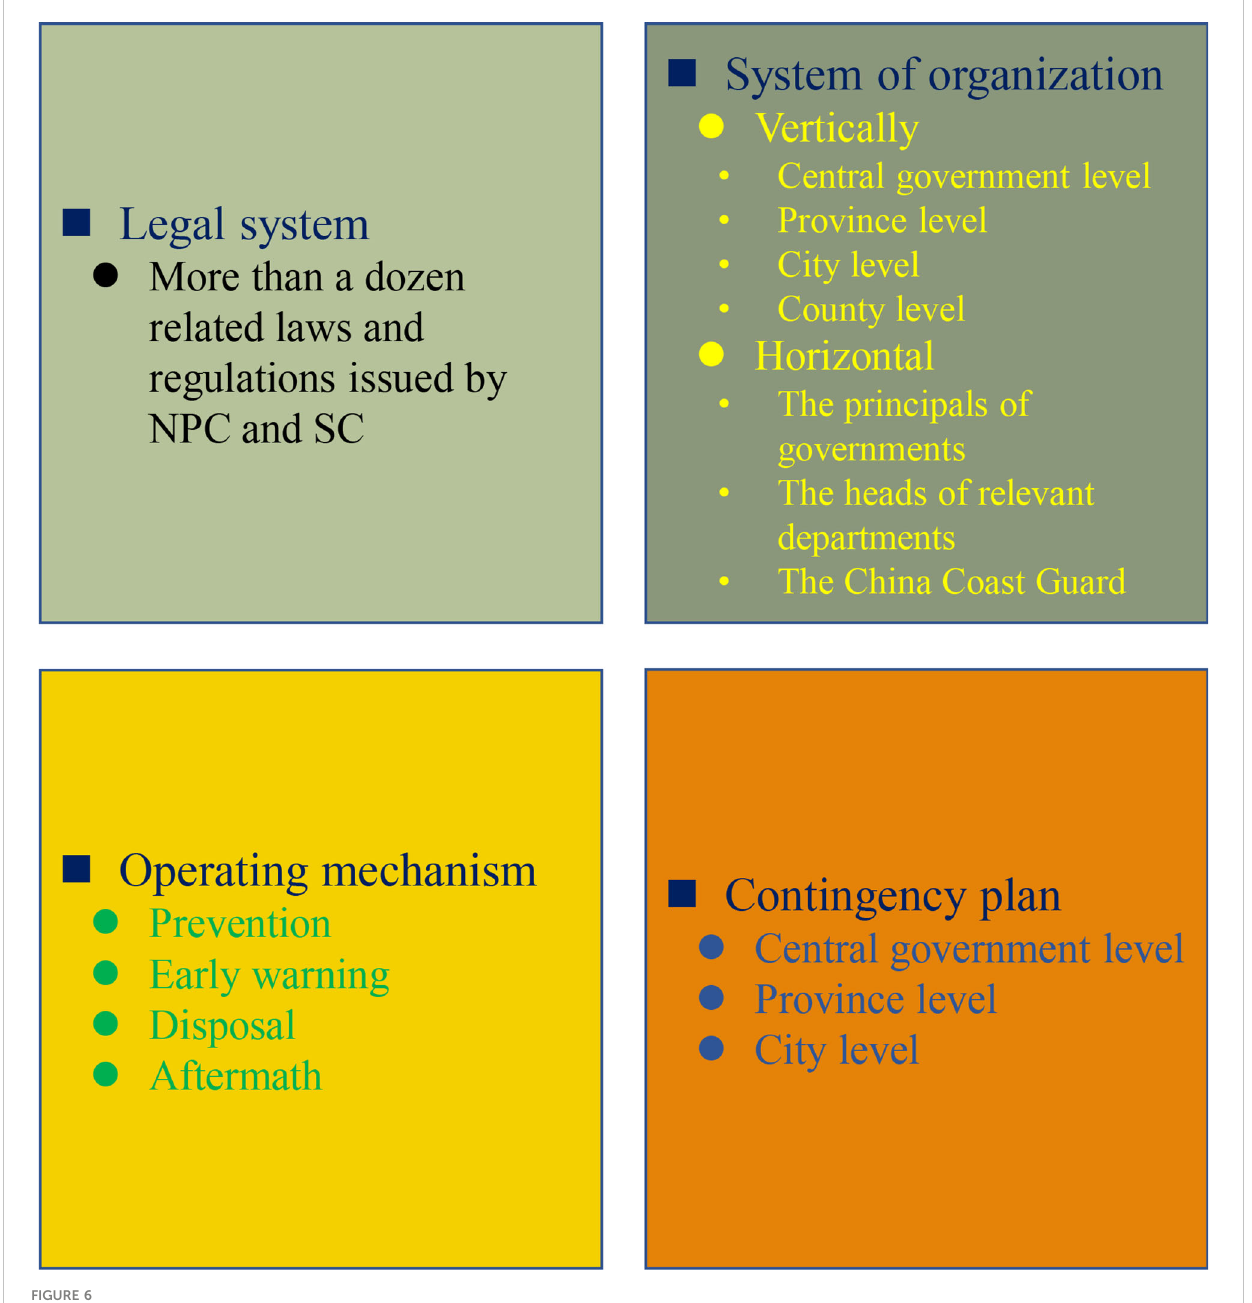
FIGURE 6 Disaster emergency management system in